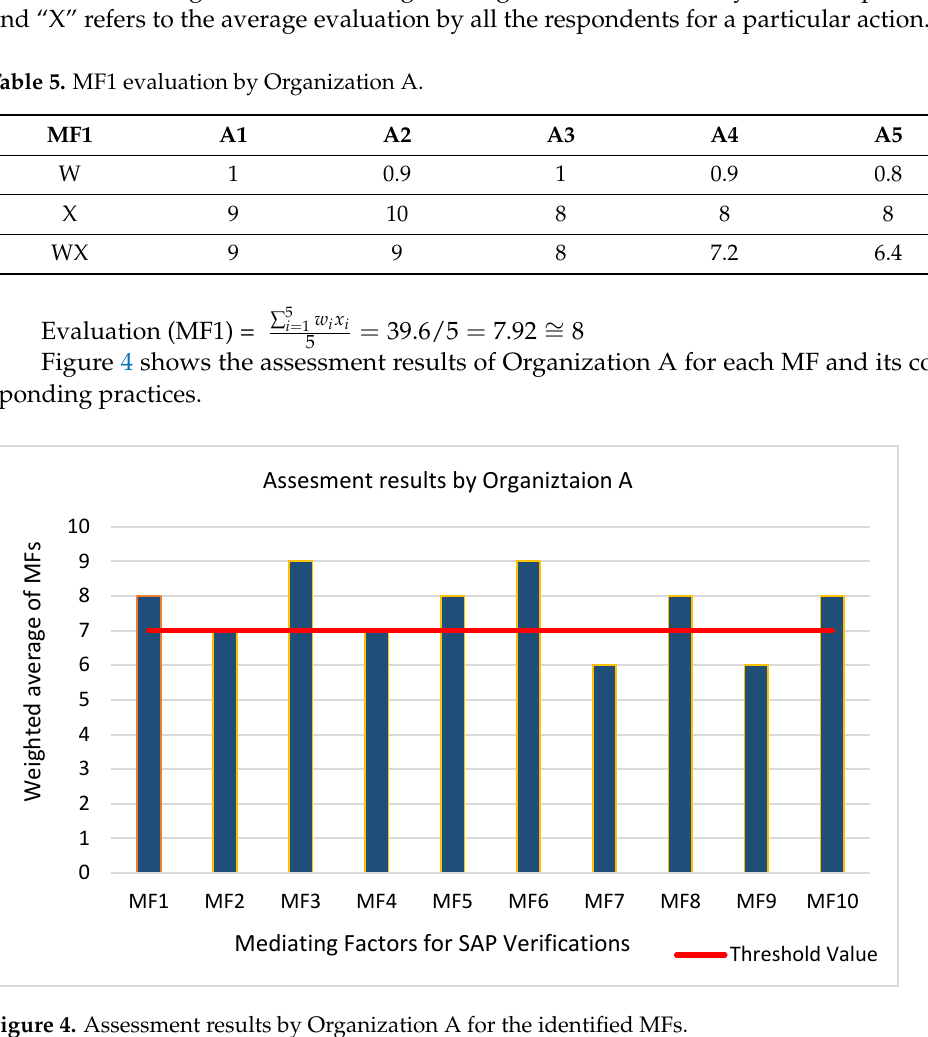
Figure 4. Assessment results by Organization A for the identified MFs .